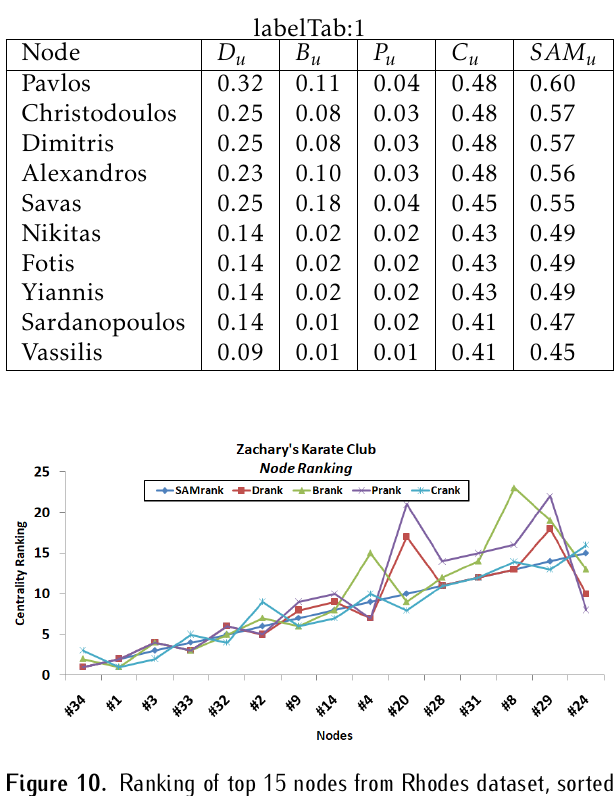
Figure 9. Centrality score of top 15 nodes from Jakarta dataset, sorted by SAM centrality